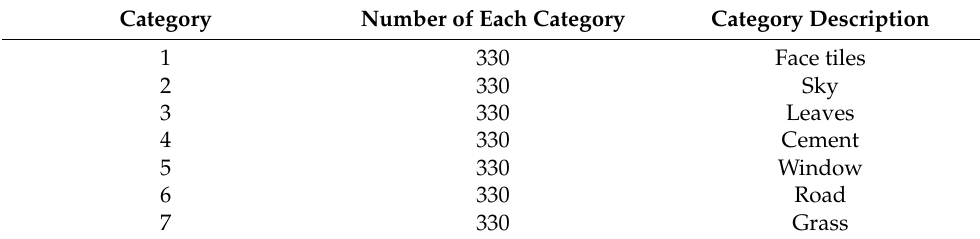
Table 4. Details of the image segmentation dataset.